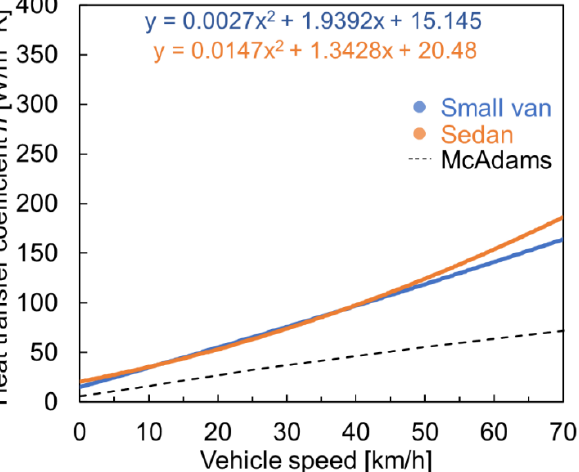
Figure 8. Empirical equations of the averaged convective heat transfer coefficient over the positions along the center line of the roof (F1, F3, F5 and F7): small van (blue), sedan (orange), and McAdams (black).